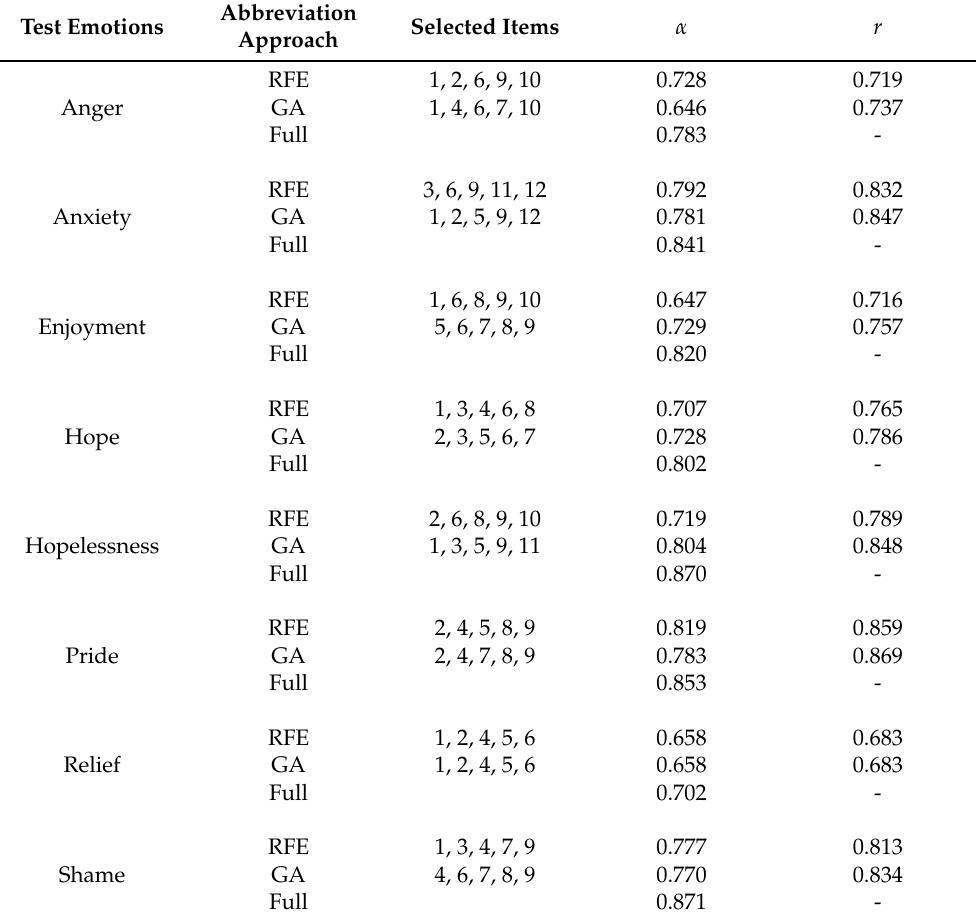
Table 1. Reliability and correlation results for the full-length and abbreviated subscales of the